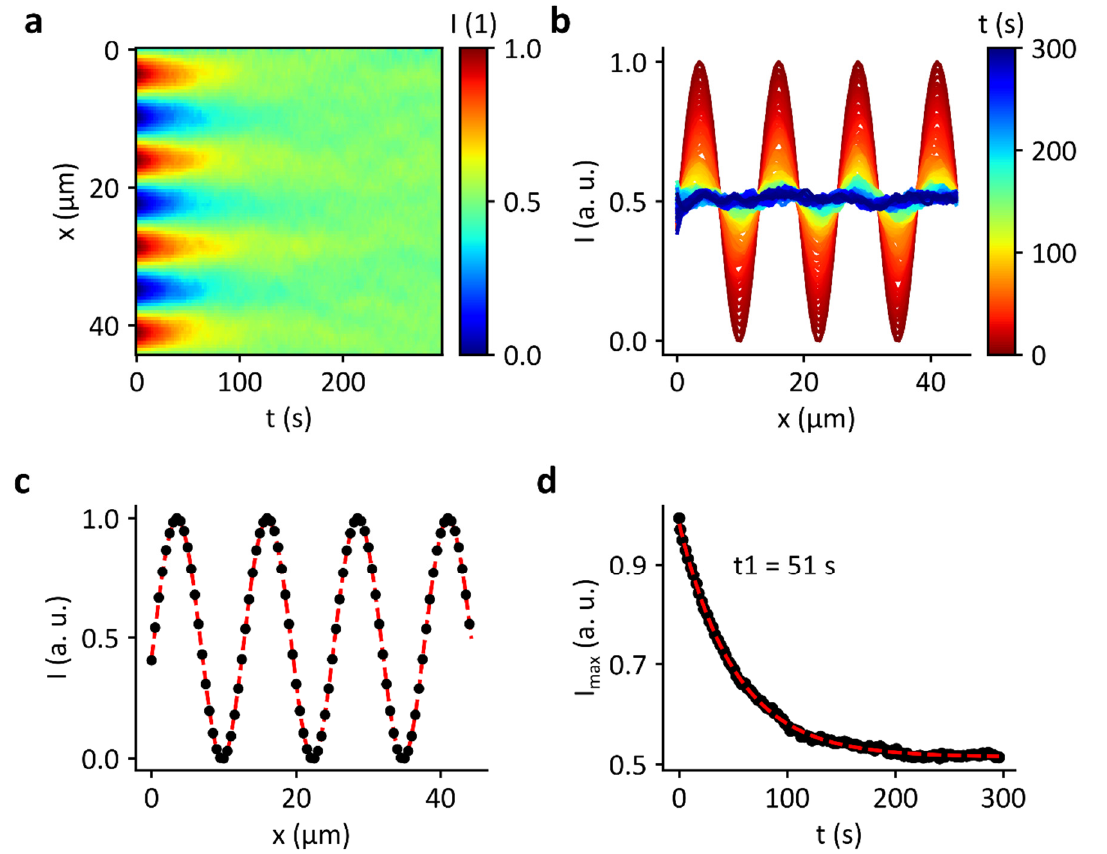
Figure 8. Simulation of domain decay in an SLB. ( a ) Heatmap of the normalized brightness intensity over 300 s. ( b ) Intensity profile perpendicular to the pattern of stripes. ( c ) Fitted intensity curve for t = 0 s. ( d ) Time course of the intensity maximum of the fit curves. After about 100 s, the stripe pattern has almost completely disappeared.